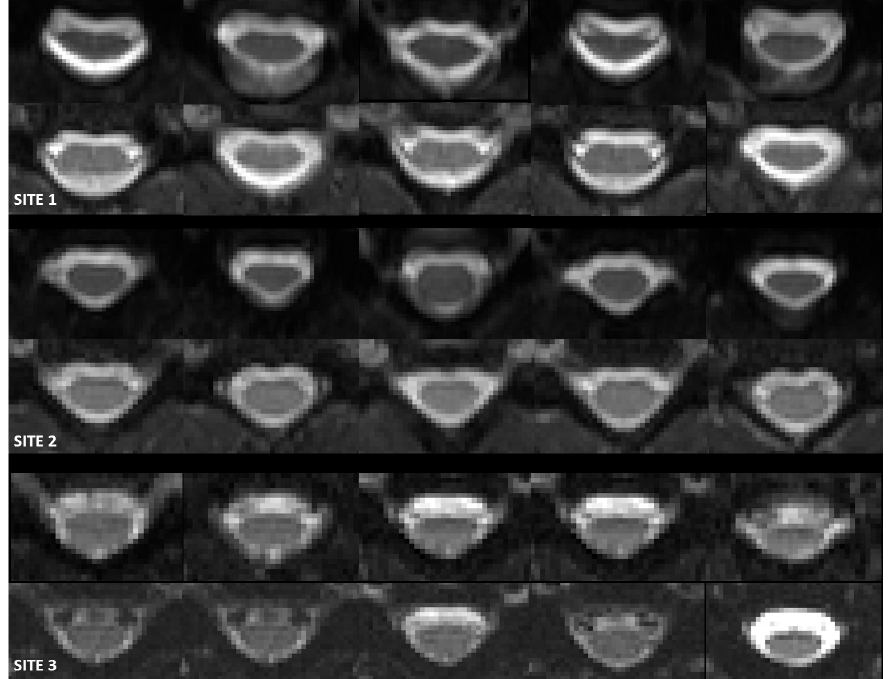
Fig 2. Central 5 slices of mean b 0 images for an example single subject (not the same subject at each of the three sites) for the OVS protocol (top), followed by the rFOV protocol (bottom), acquired at each of the 3 sites (London, Vanderbilt and Montreal; 1 – 3 from top to bottom,